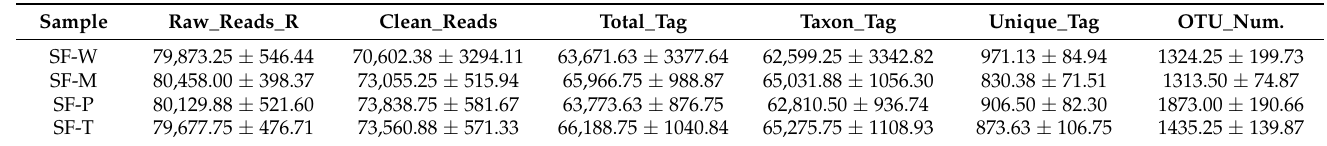
Table 1. Statistics of effective sequencing data of bacterial 16S rRNA in the larval S. frugiperda .